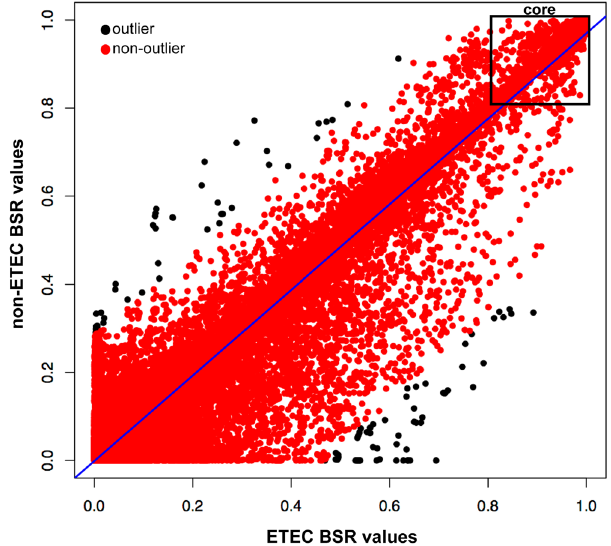
Figure 3. A comparison of BSR values 69 between ETEC (n = 253) and non-ETEC (n = 253) in phylogroups A and B1. A total of 118 genes that are outliers are identified and shown in black as defined by the MASS package in R. A functional breakdown of these genes is listed in Table S4.